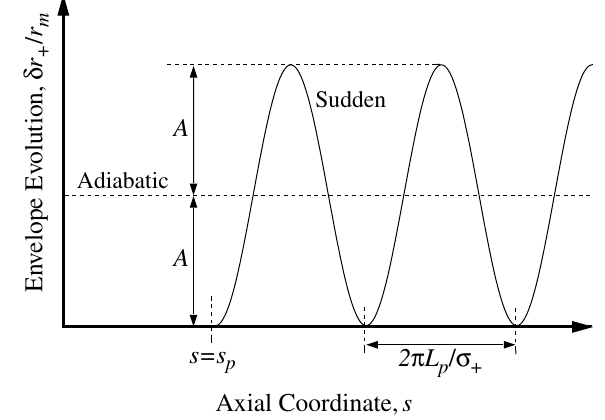
FIG. 9. Contrast of the envelope response %r (cid:5) (cid:3) s (cid:4) to sudden and adiabatic driving emittance perturbations with (cid:3) c %"%" c %"%" y =" (cid:4) = 2 > 0 that achieve the same value of emittance change for s > s p